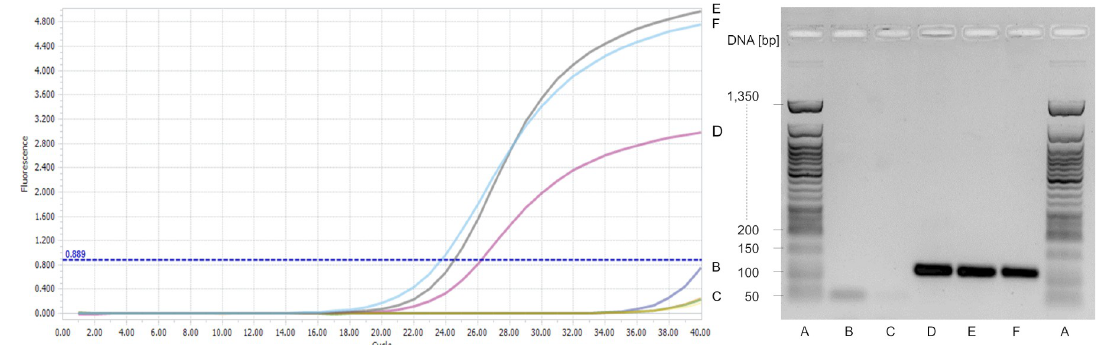
Fig 4. Amplification curves and agar gel electrophoresis of real—time PCR for pediocin PA-1 structural gene detection in Pediococcus acidilactici LMQS154.1 and Pediococcus pentosaceus LMQS 331.3 by primer S13 [32]. A: 50 bp DNA Ladder (New England Biolabs GmbH, Frankfurt, Germany); B: Master Mix, negative control; C: Pediococcus acidilactici DSM 20284, negative control; D: Pediococcus acidilactici LMQS 20.1, positive control; E: Pediococcus pentosaceus LMQS 331.3, traditional product; Pediococcus acidilactici LMQS 154.1, industrial